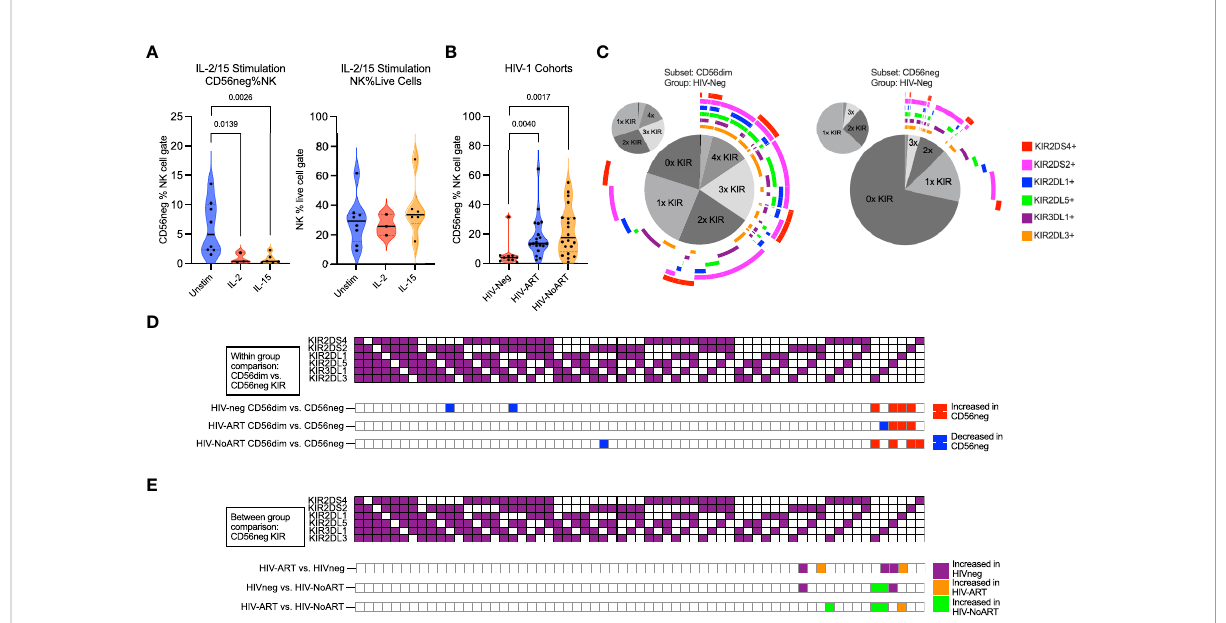
FIGURE 3 CD56neg subset frequency with IL-2 or IL-15 stimulation, frequency in HIV-1 dataset, and subset KIR repertoire comparison. (A) reduced CD56neg % NK when stimulated by IL-2 or IL-15 (FR-FCM-ZYZ3). CD56neg populations with under 100 events were excluded from analysis. (B) the frequency of the CD56neg subset within NK cells in HIV-1 - and HIV-1 + individuals on/not on ART (SDY1535). Kruskal-Wallis tests corrected for FDR were used for both analyses. (C) combinations of KIRs expressed by CD56dim and CD56neg cells in HIV-1 - group (SDY1535). The central pie chart shows proportion of subset expressing no KIR, one KIR, or combinations of KIRs. Surrounding bars denote the presence of KIRs corresponding to the legend color. The smaller orbiting pie charts show proportion of subset KIRs when KIR-negative cells were excluded. (D) comparison of KIR repertoire frequency between CD56dim and CD56neg subsets within each of the HIV-1 - , HIV-1-ART, and HIV-1-NoART groups (SDY1535), with signi fi cantly larger (p < 0.05) KIR combination proportions on CD56neg (red) and CD56dim (blue) shown using two-way ANOVA. (E) impact of HIV-1 and ART status on KIR combination frequency within the CD56neg subset through between study group comparisons (HIV - – purple, HIV-ART – orange, HIV-NoART –